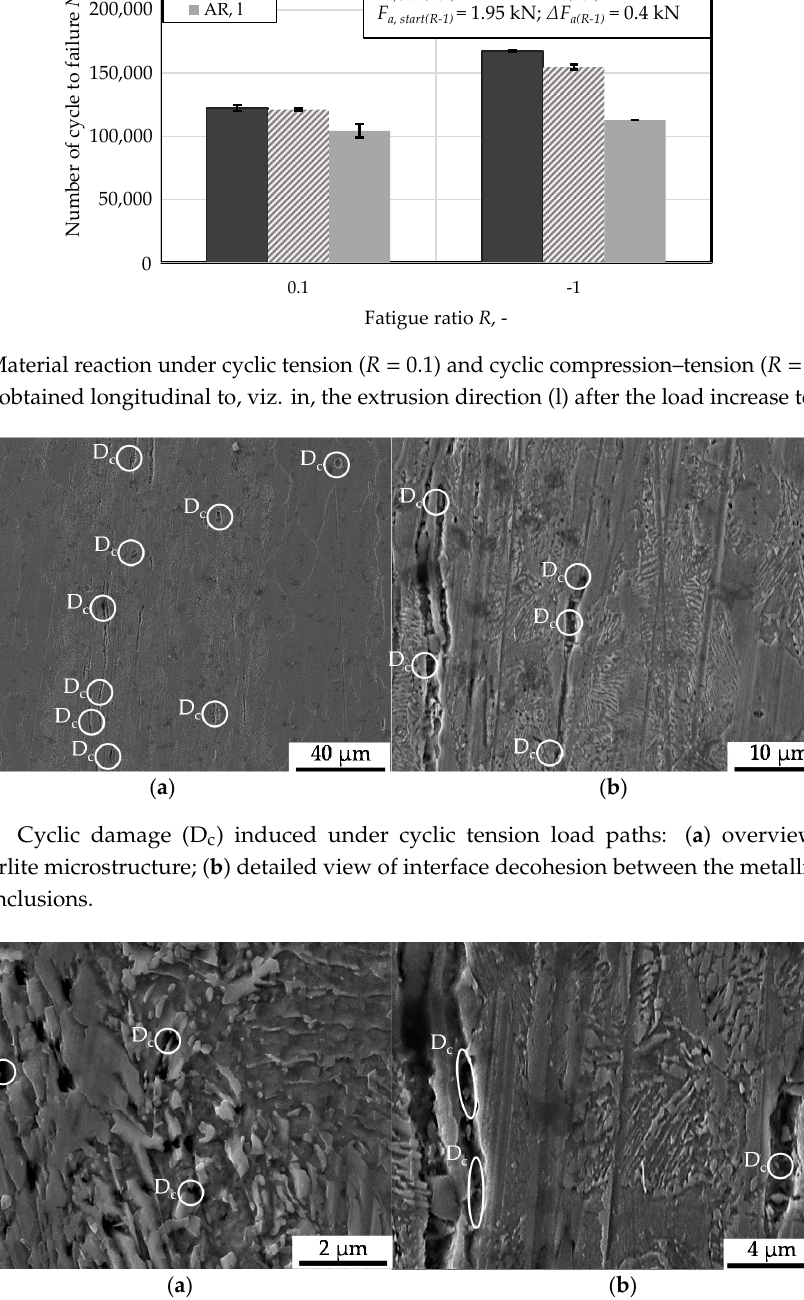
( b ) Figure 8. Cyclic damage (D